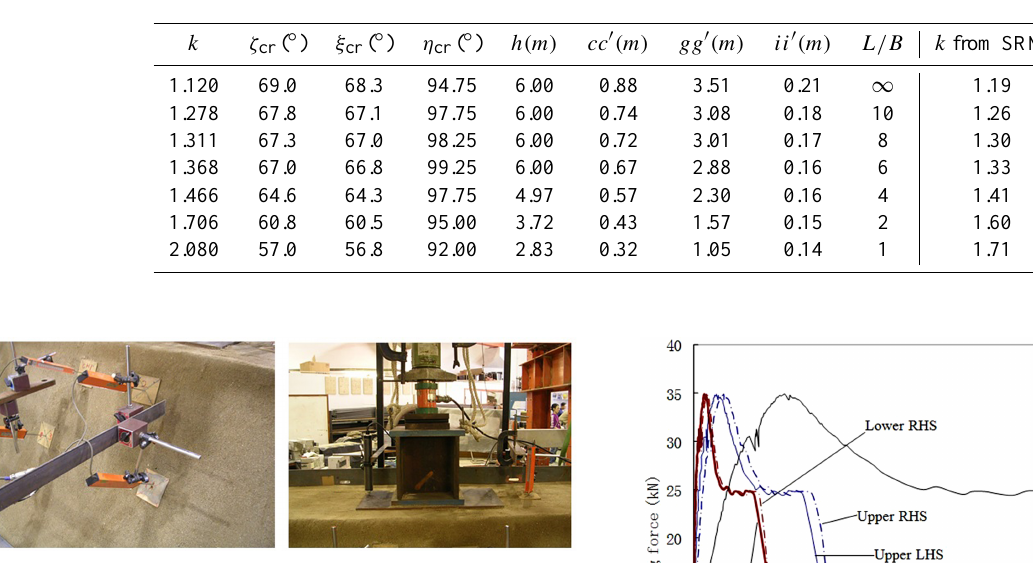
Figure 7. LVDT at top and sloping face of the model test.